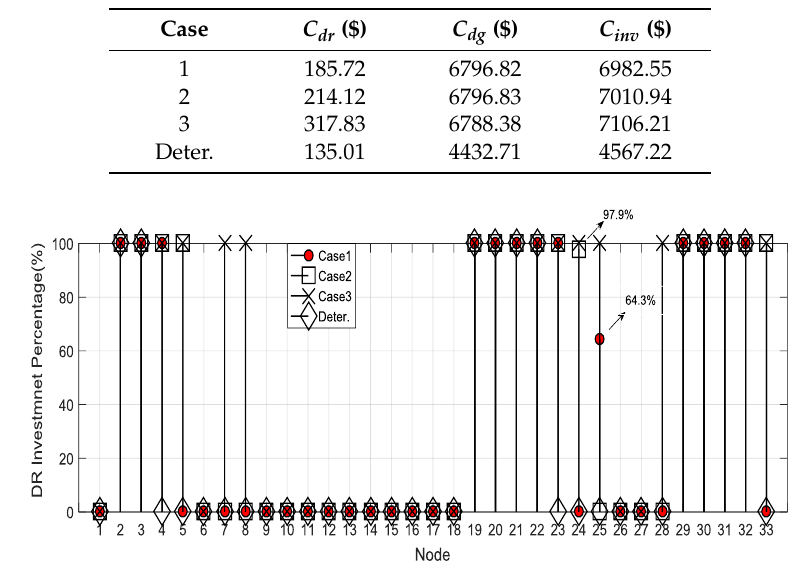
Figure 5 . Demand response (DR) Investment Scheme in different cases. Figure 5. Demand response (DR) Investment Scheme in different